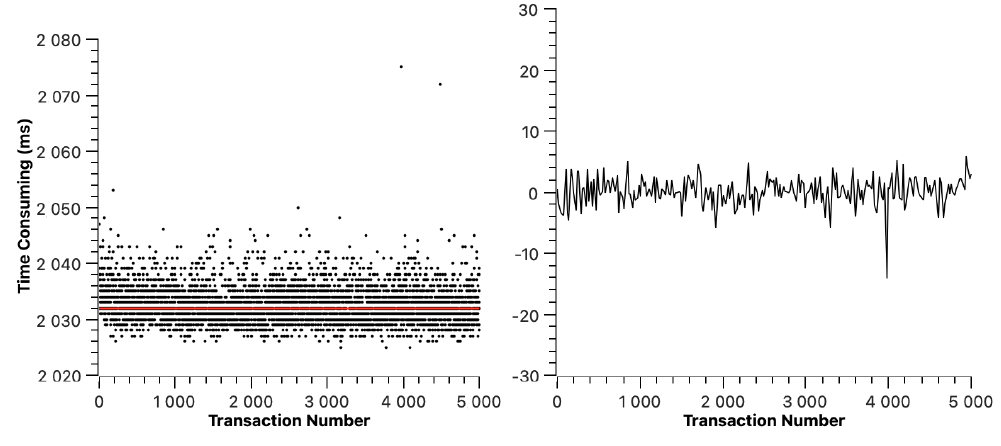
Figure 6. Fabric cross-chain transaction resolution time.